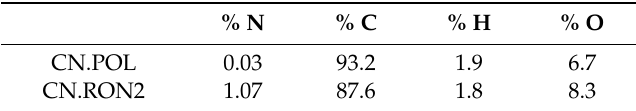
Figure 3. FTIR spectra of CN.POL and CN.RON2. Table 4. Elemental analysis of nanoparticles synthesized with resorcinol/formaldehyde (CN.POL) and cane molasses (CN.RON2).